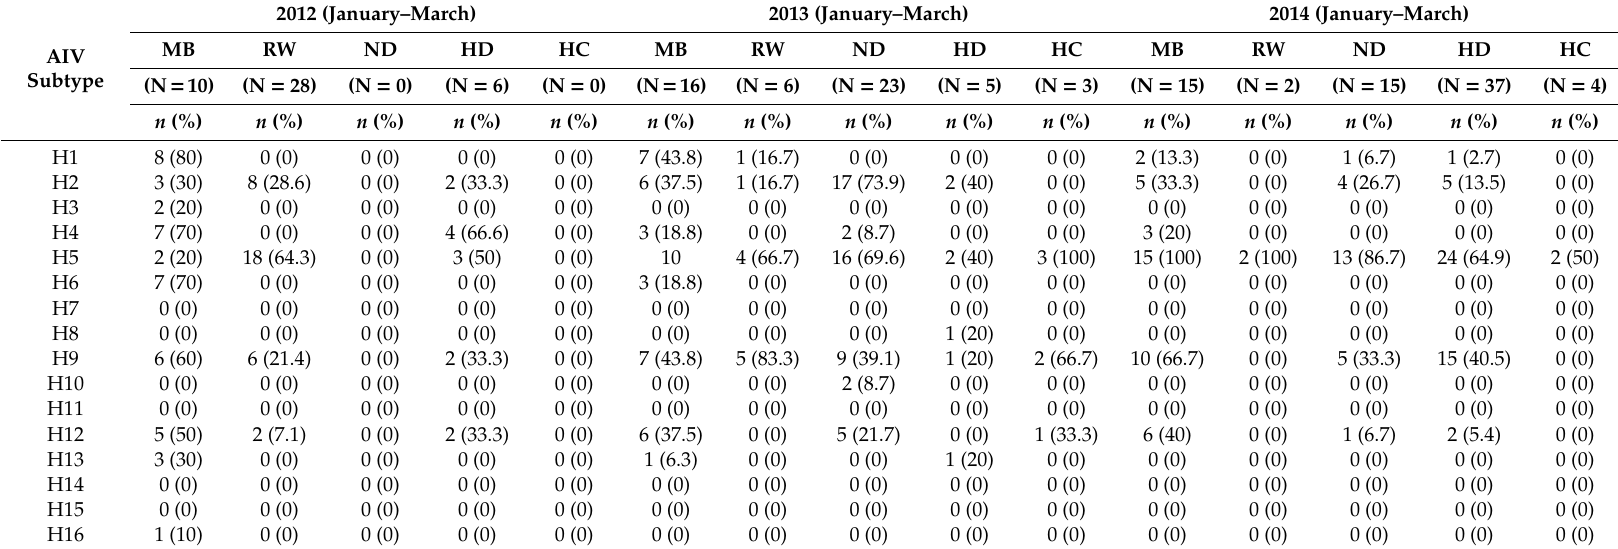
Table 2. Year versus haemagglutinin (HA) serotypes for di ff erent groups of birds in